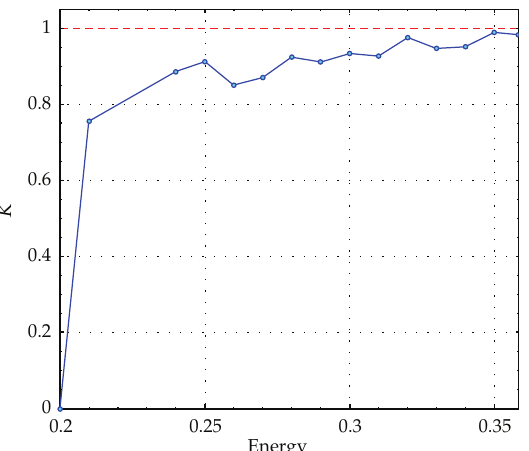
Figure 5: Index K versus Energy in fifth-order Hamiltonian. The red dashed line corresponds to K (cid:7) 1.